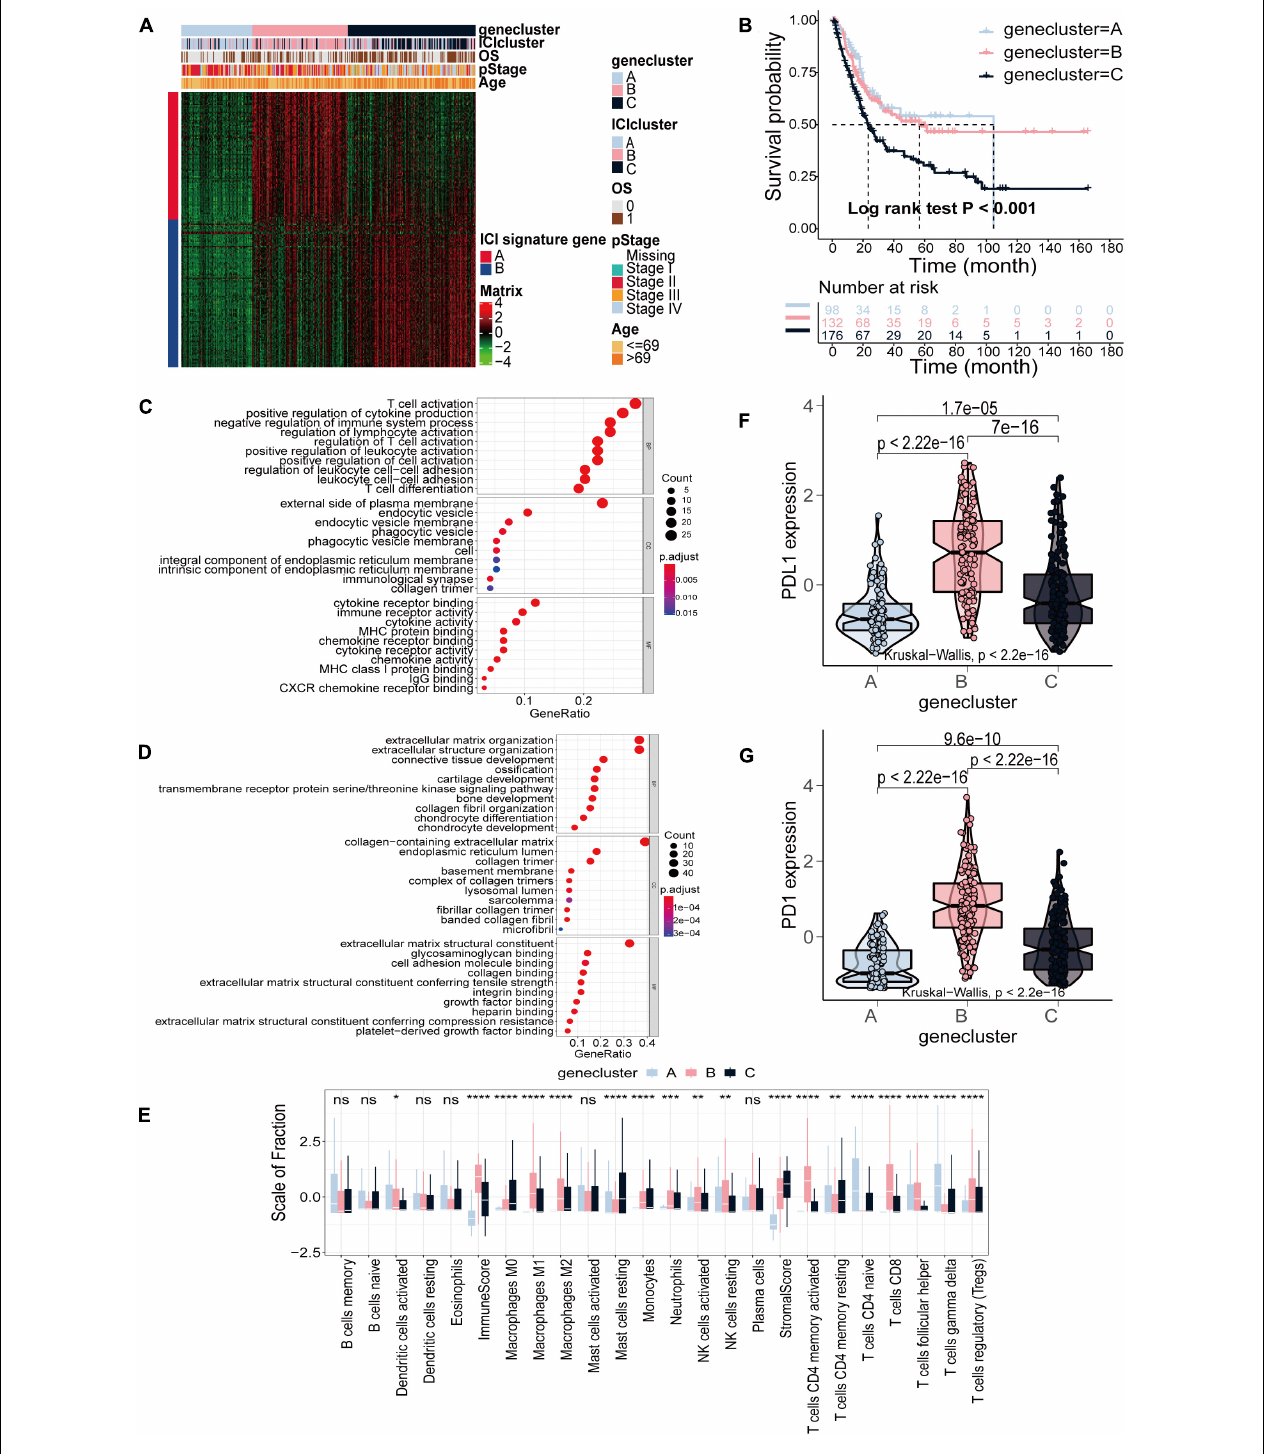
FIGURE 2 | Identification of gene subtypes based on DEGs in TCGA-BLCA cohort. (A) Consensus clustering of DEGs among three ICI subtypes. (B) Kaplan–Meier curves for OS of the three gene clusters (log-rank test, p < 0.001). (C,D) GO enrichment analysis of the two ICI-related signature genes: ICI signature genes A (C) and ICI signature genes B (D) . (E) The fraction of TIICs, immune score and stromal score in three gene clusters (Kruskal–Wallis test, * p < 0.05; ** p < 0.01; *** p < 0.001; **** p < 0.0001). (F,G) The difference in the expression of PD-L1 (F) and PD-1 (G) among three gene clusters (Kruskal–Wallis test, p < 2.2e-16).